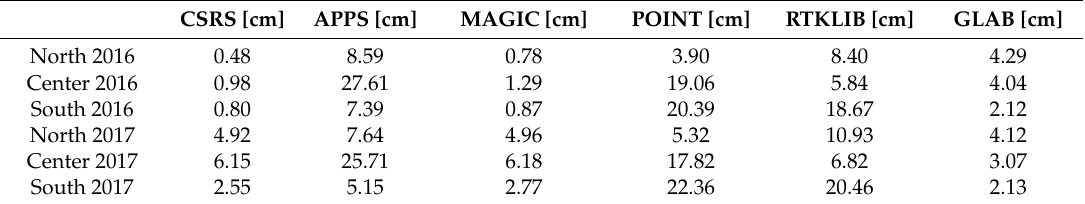
Table 3. RMSE values in centimeters by groups for day January 27th 2016 and 2017.